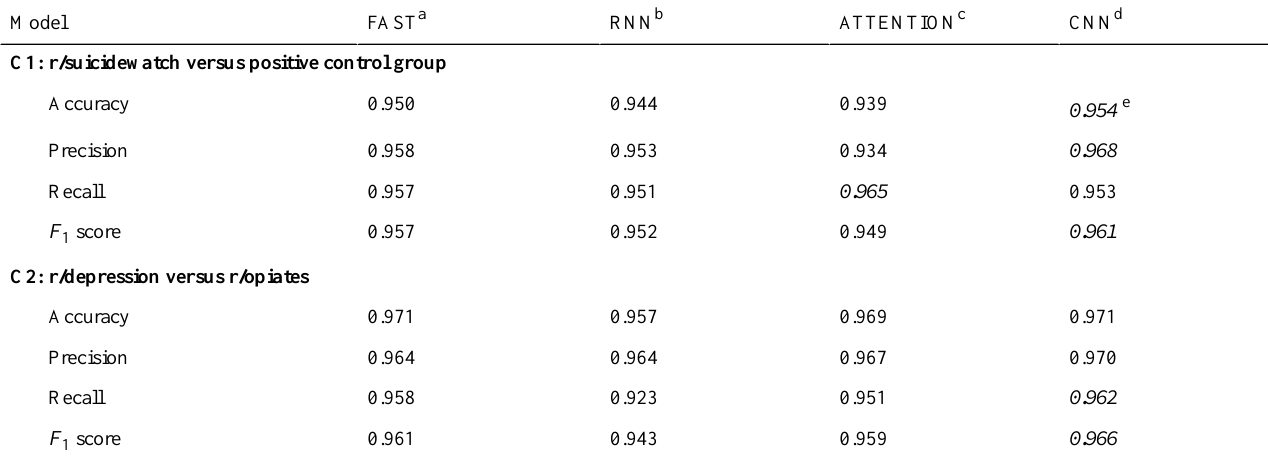
Table 4. Comparison of text classification neural network baselines with word embedding and convolutional neural